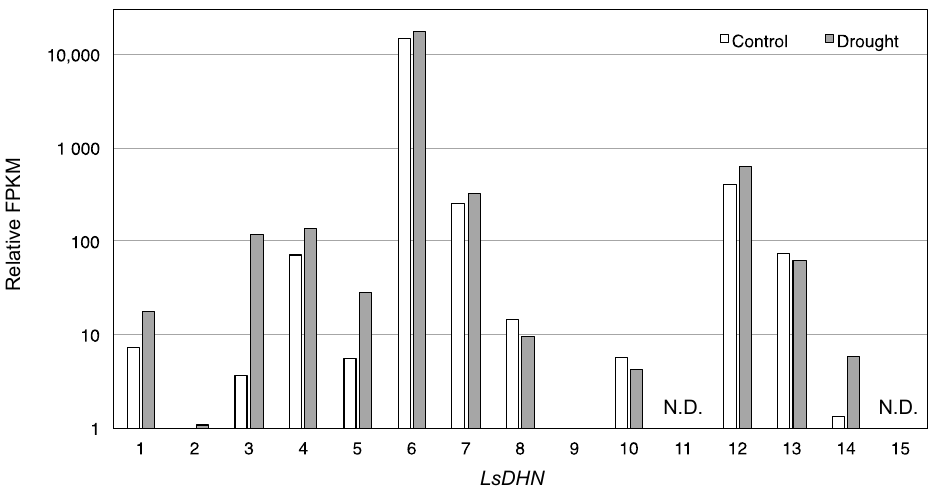
Figure 4. Relative expression of DHN s during dehydration in lettuce. The relative expression of DHN was compared via RNA-seq. The expression levels of DHN were compared with the fragments per kilobase per million reads (FPKM) between the control (white) and drought stress (gray). Each relative FPKM was calculated on the basis of the control treatment of LsDHN9 and plotted on the axis of a logarithmic